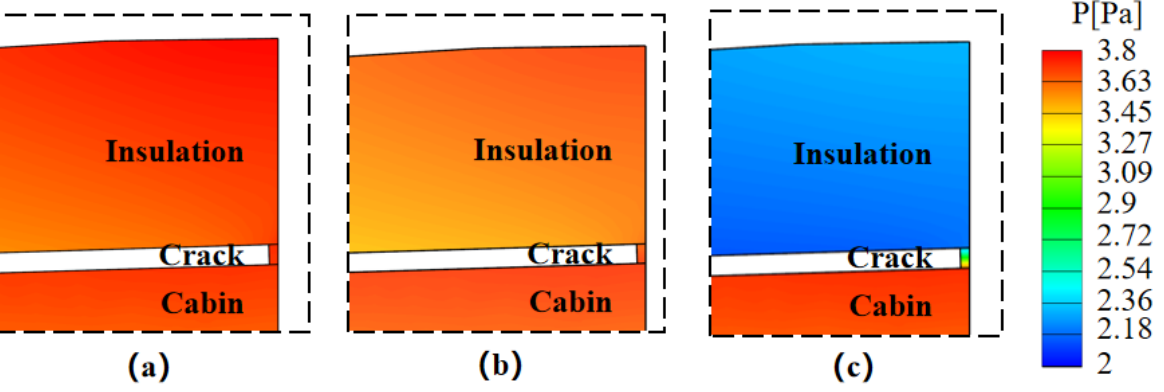
Figure 10. Pressure distribution near Crack 1 with different crack sizes: ( a ) 5 mm, ( b ) 2.66 mm, ( c ) 1